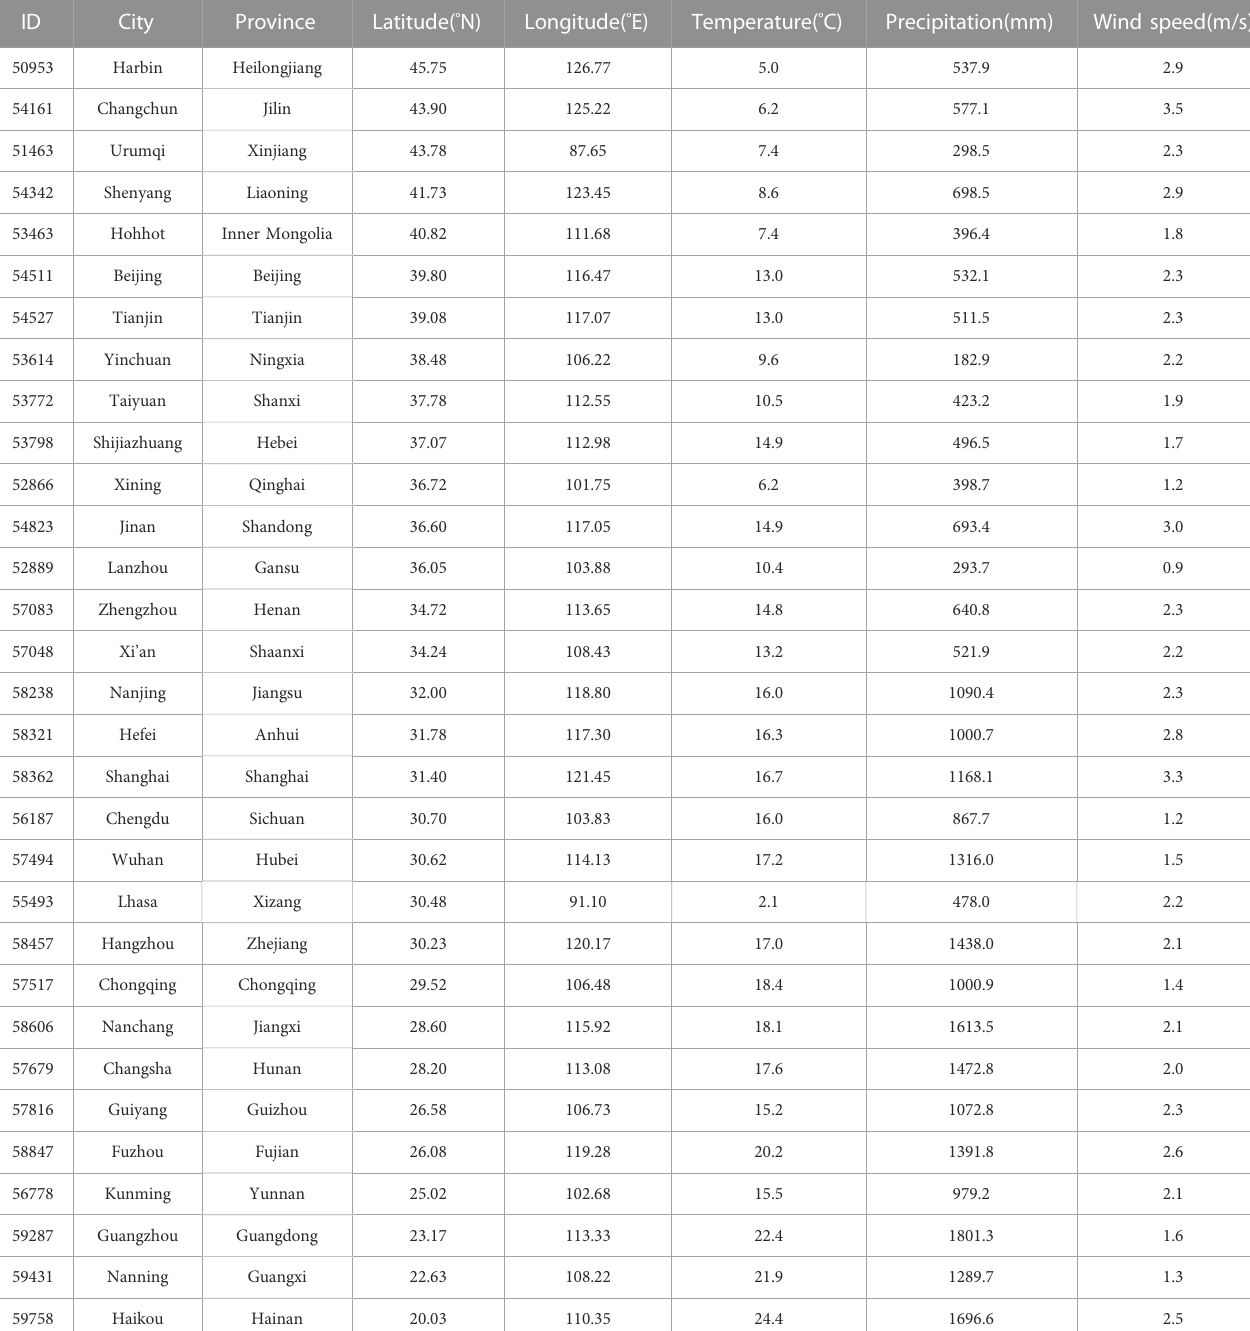
TABLE 1 Basic information for 31 provincial capitals in mainland China. ID